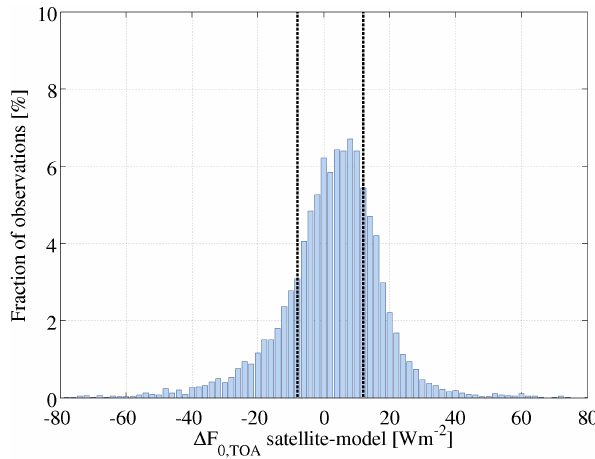
Figure 9. Differences of F 0 , TOA obtained from satellite-based fit- ting method and radiative transfer model simulations including all pixels within the study area from March to October 2009. The black dashed lines indicate − 10Wm − 2 and 10Wm − 2